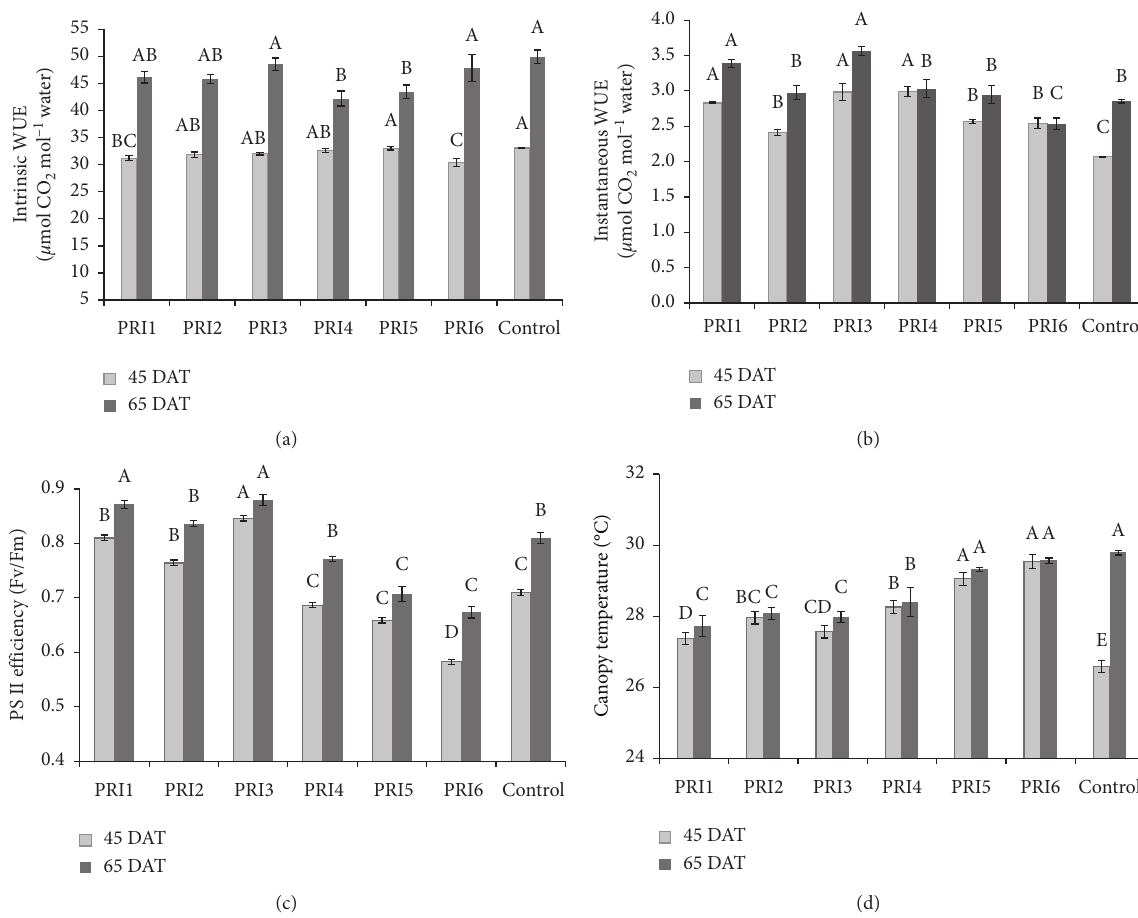
Figure 4: Leaf water use efficiency, photosystem efficiency, and canopy temperature measurements of rice under the split root experiment. Changes in leaf intrinsic ( P N / g s ) (a), instantaneous ( P N / T r ), (b) Water Use Efficiency, photosystem efficiency (PS II efficiency) (c), and canopy temperature (d) at different partial root-zone irrigation treatments. Error bars indicate one standard error of the mean. Different letters denote significant differences among means derived using an ANOVA and Student’s t -test.